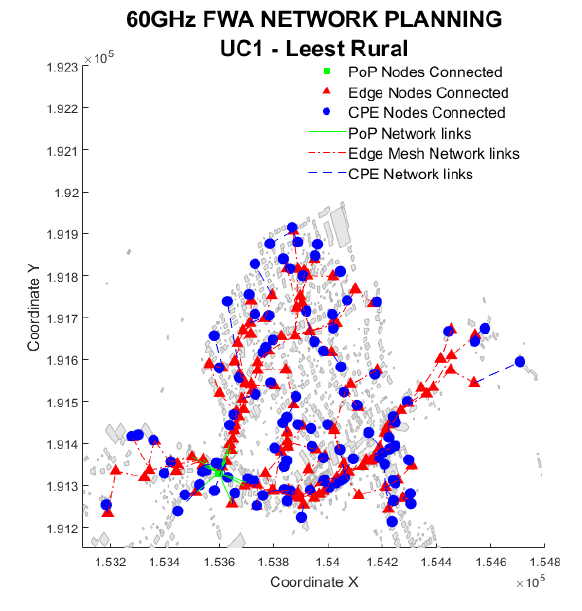
Figure 7. Use Case 1 solution example. Snapshot of the rural Leest